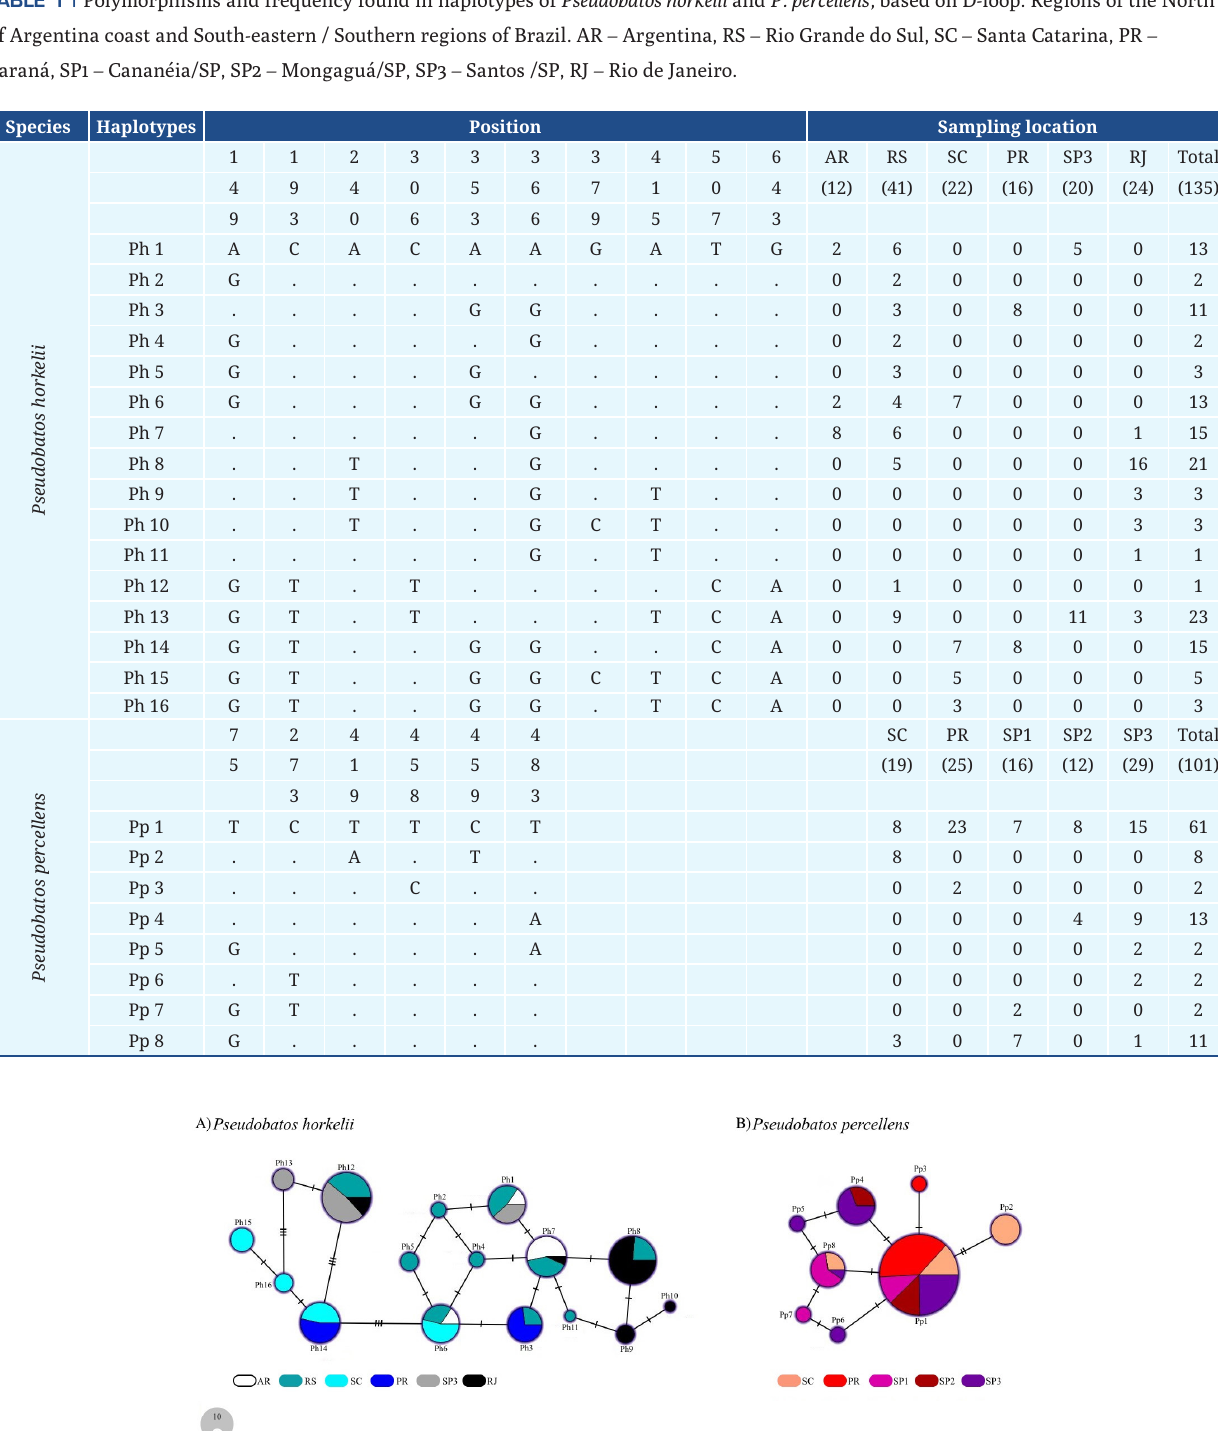
FIGURE 1 | Median-joining network of mtCR haplotypes for A. Pseudobatos horkelii and B. Pseudobatos percellens . Haplotypes are represented by circles with size proportional to frequency in the total sample. All hatch marks correspond to one mutation. Samples from northern Argentina (AR), Torrinha/RS (RS), Florianópolis/SC (SC), Pontal do Paraná/PR (PR), Cananéia/ SP (SP1), Mongaguá/SP (SP2), Santos/SP (SP3), Rio de Janeiro/RJ(RJ).